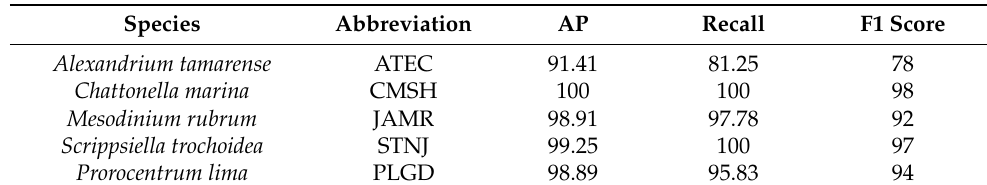
Table 4. Detection effect of plankton.